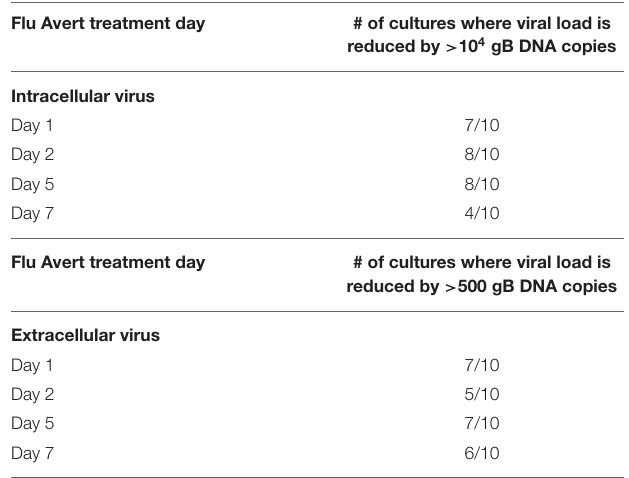
TABLE 3 | Number of cultures in which EHV-1 viral load was reduced by Flu Avert treatment. Flu Avert treatment day # of cultures where viral load is reduced by > 10 4 gB DNA